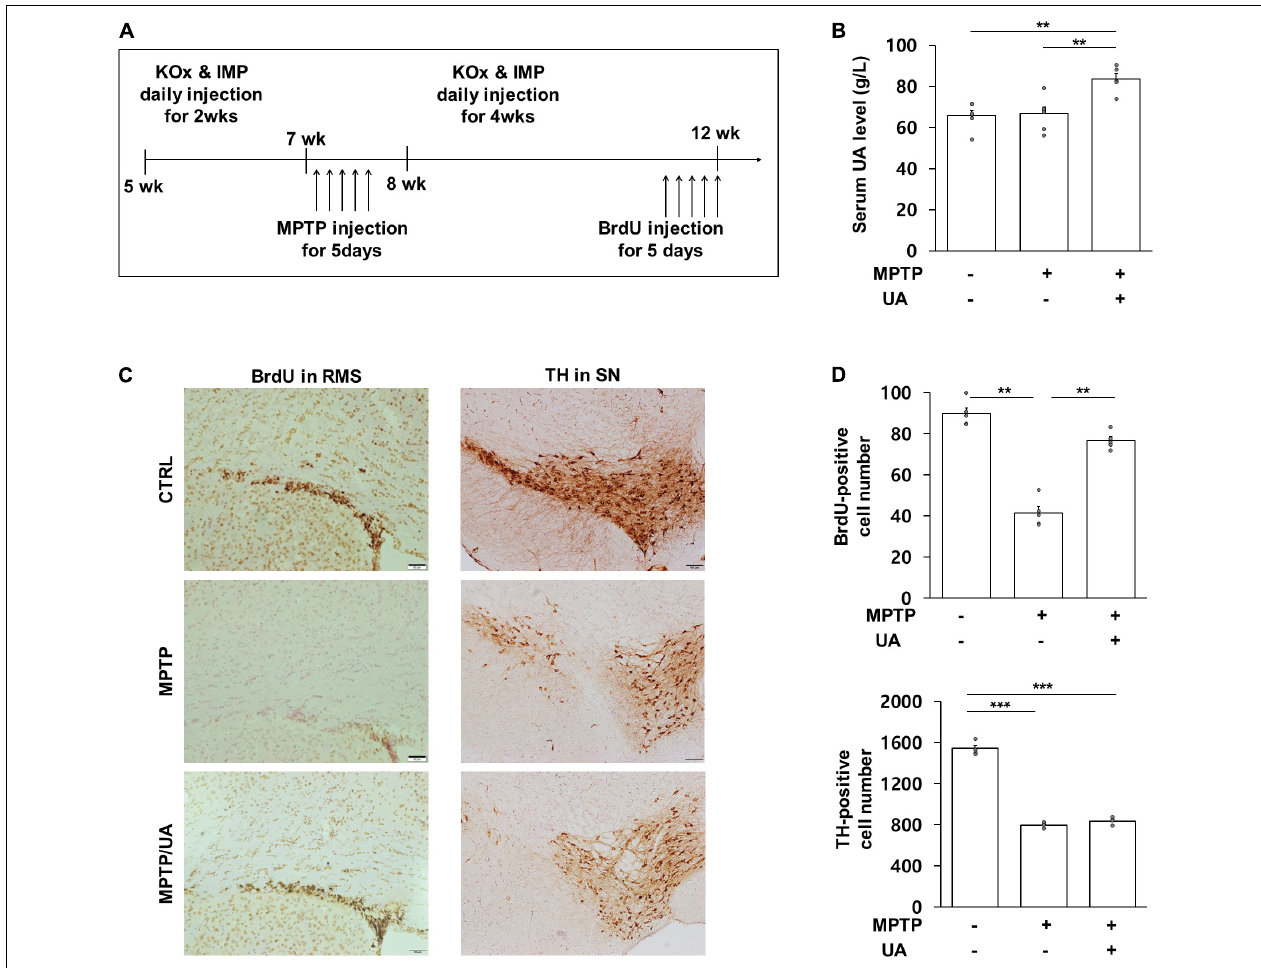
FIGURE 1 | UA elevation increased the number of BrdU-positive cells in the SVZ of a MPTP-induced PD animal model. (A) Animal experimental schedule design. (B) Serum UA levels were significantly higher in mice that received IMP with KOx as compared to control and MPTP-treated mice ( n = 8 per group). (C,D) The number of BrdU-positive cells in SVZ at 12 weeks. PD mice with high serum UA levels showed considerably more BrdU-positive cells as compared to PD mice with normal serum UA levels ( n = 5 per group). The number of TH-positive cells in the SN at 12 weeks. Both PD mice with high and normal UA levels revealed a significant reduction in the number of TH-positive cells compared to the control group. There was no statistically significant difference between PD mice with high serum UA levels and those with normal levels ( n = 5 per group). Differences among the conditions were evaluated by ANOVA with a Bonferroni correction for multiple comparison. The data are presented as mean ± SE. ** p < 0.01 and *** p < 0.001.